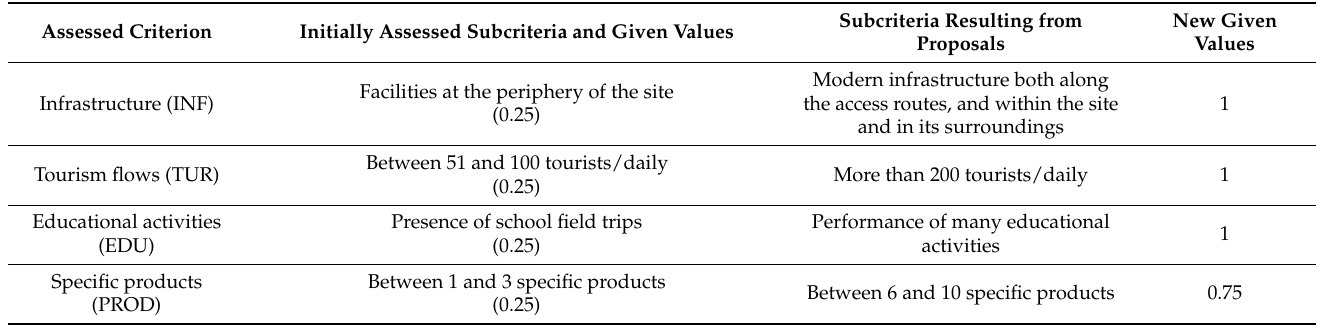
Table 8. Reassessment of the criteria as a result of